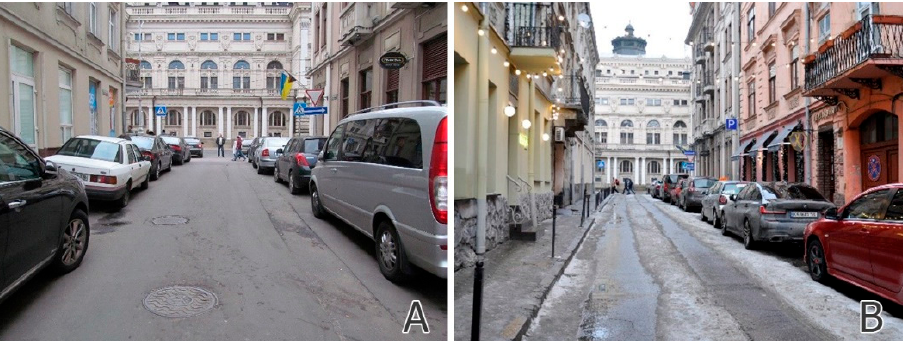
Figure 12. ( A ) Parked sidewalk, which blocks pedestrian movement on Furmanska Street (2016). ( B ) Parking barriers (columns) protect the sidewalk from the former chaotic parking (2021). Photo by R. Liubytskyi.